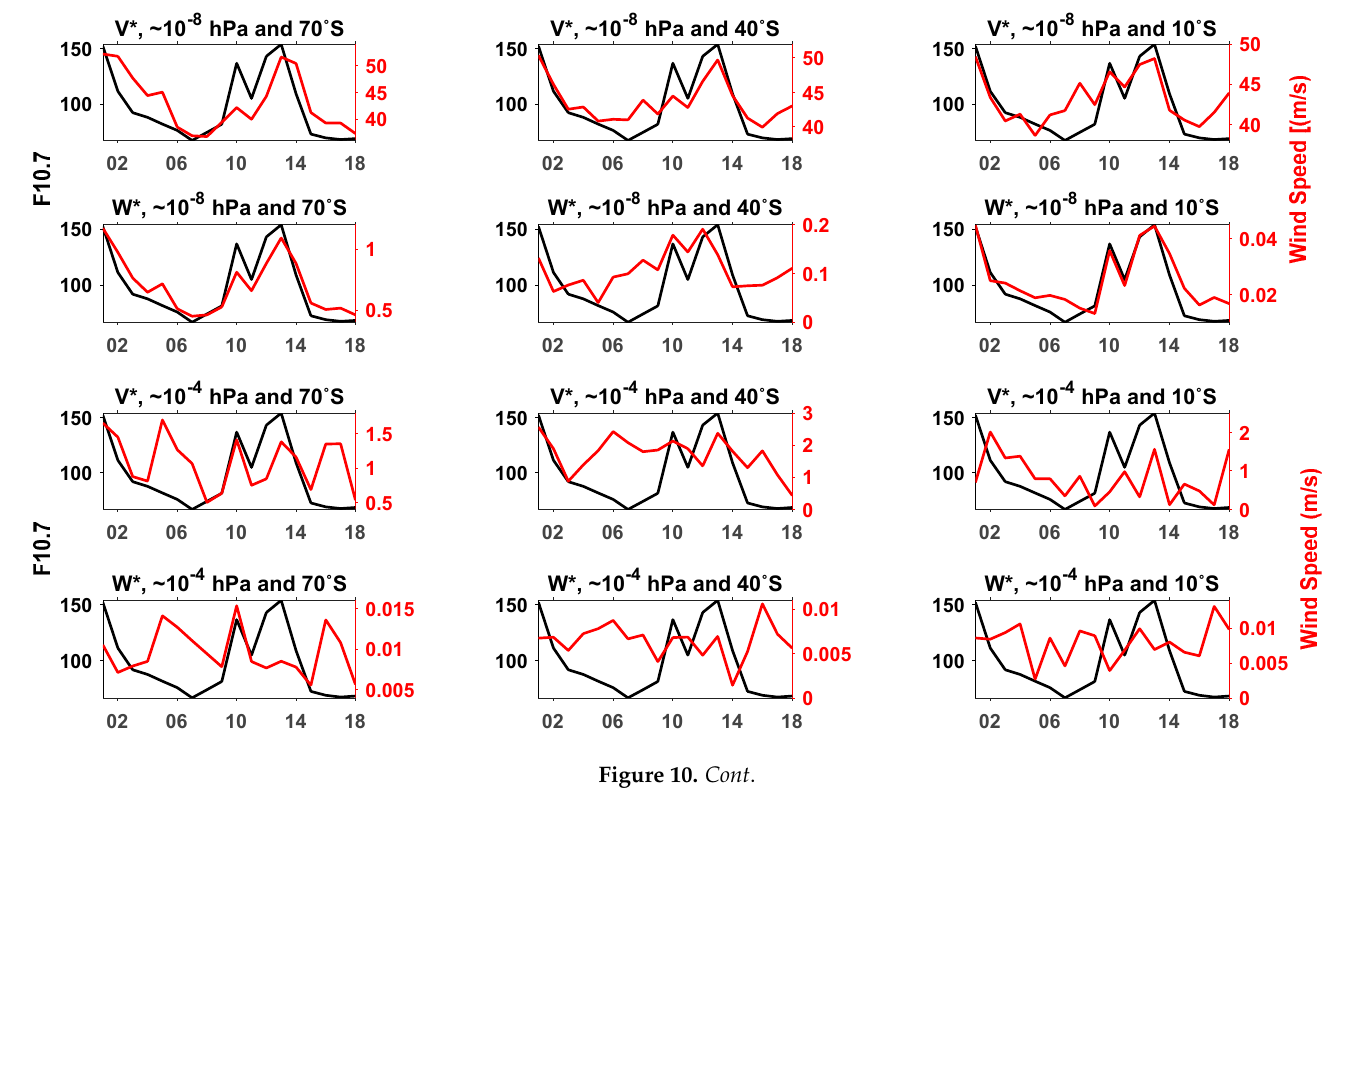
Figure 10. Time series of the meridional and vertical components of atmospheric circulation at a specified altitude (~10 − 8 hPa, first two rows; ~10 − 4 hPa, middle two rows; ~10 − 2 hPa, last two rows) and latitude (~70° S, left column; ~40° S, middle column; ~10° S, right column) and the F10.7 solar index in December from 2002 to 2019. The black and red lines indicate the F10.7 solar index and the corresponding component of atmospheric circulation, respectively.